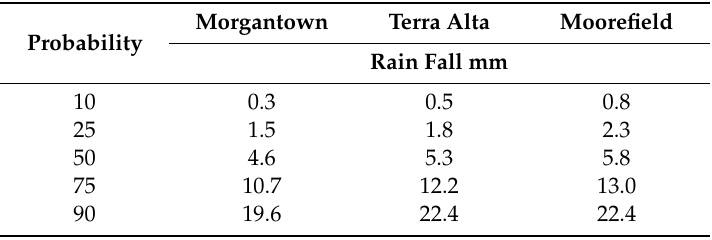
Table 7. For the three locations used for the stochastic modeling of pasture growth, the probability of daily rainfall on days when it does rain from April through October, based on historic precipitation patterns, expressed as a gamma distribution of daily rainfall amount, using growing season average alpha and beta coe ffi